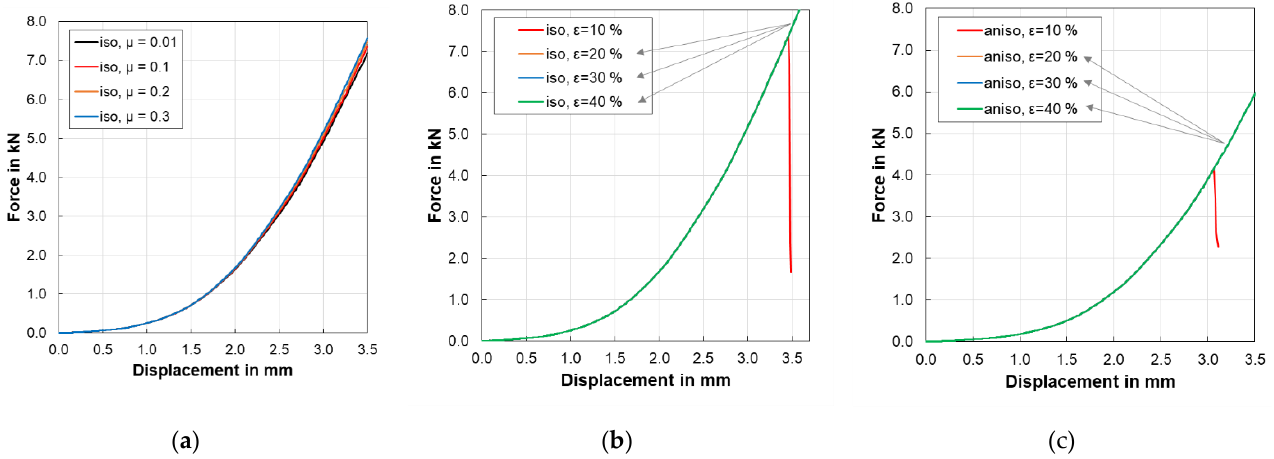
Figure 17. Force-displacement outputs using a sandwich modelling method: ( a ) influence of coefficient of friction on isotropic model; ( b ) influence of failure strain on isotropic model; ( c ) influence of failure strain on anisotropic model.